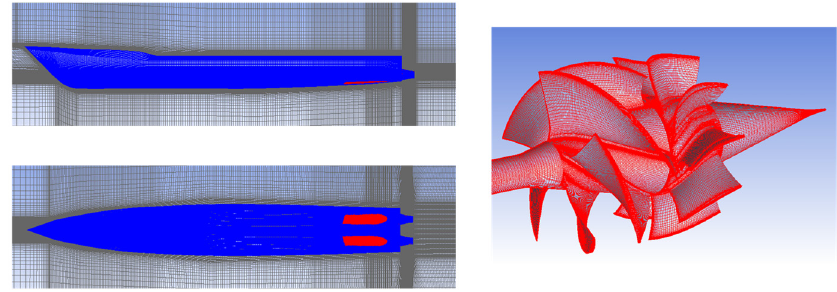
Figure 4. Computational grid system of the waterjet-propelled ship model.